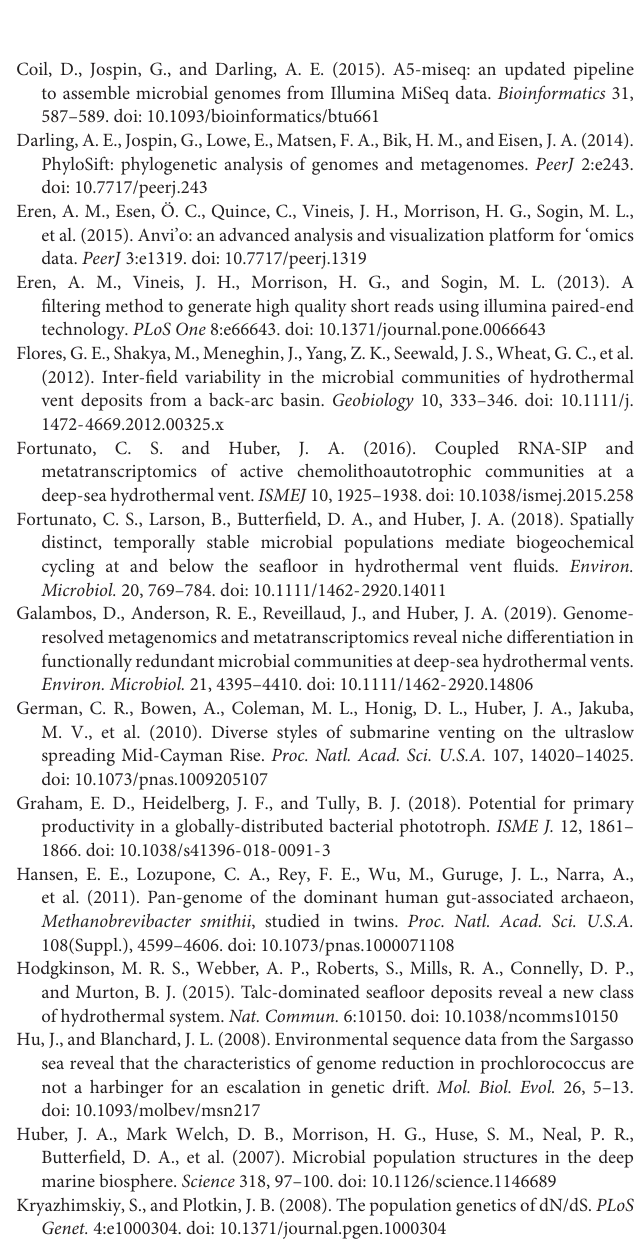
with a series of boxes, in which each box represents a spacer sequence. Matching spacers are shown in the same color; unique spacers are shown in black. Supplementary Figure 3 | Plot of SNVs per kilobase pair vs. n2n1 (majority allele frequency) for metagenome mappings to single cell amplified genomes from Piccard (yellow) and Von Damm (blue) vent fields. All y-axes reflect n2n1, or the ratio of the second most common allele to the most common allele. Bubble diameter corresponds to the average coverage of each SAG-metagenome mapping normalized by number of metagenomic reads. Bubbles are colored according to which vent field they came from; sample numbers are indicated. Supplementary Figure 4 | Scatterplots of average mapping coverage vs. average number of SNVs per kilobase pair of DNA for metagenomic mappings,